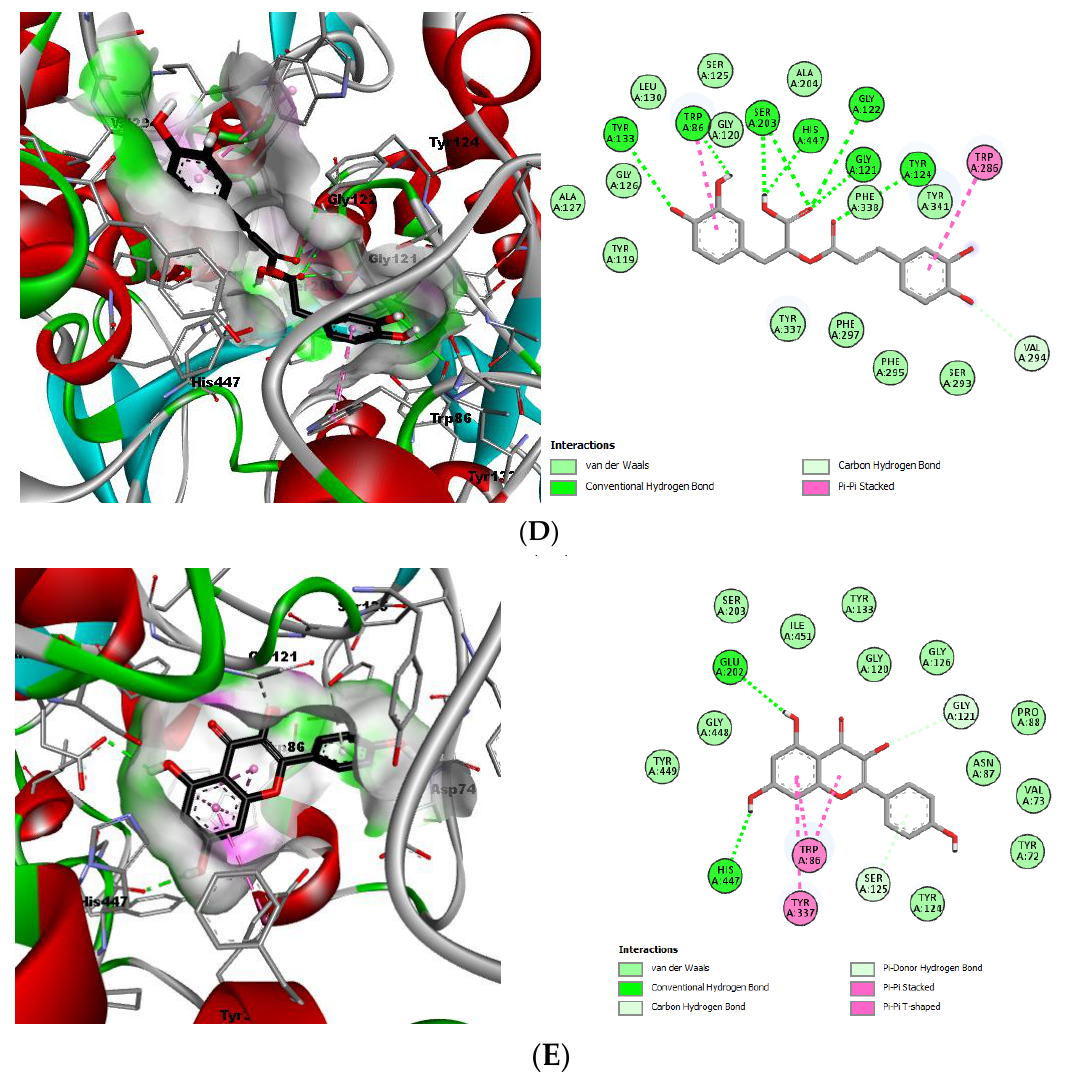
Figure 3. Predictions of the top-five ligands ’ binding modes with AChE (4EY6). Profile view and 2D schematic diagrams of ( A ) luteolin, ( B ) quercetin, ( C ) naringenin, ( D ) rosmarinic acid, and ( E ) kaempferol, trapped in AChE ’ s gorge pocket.